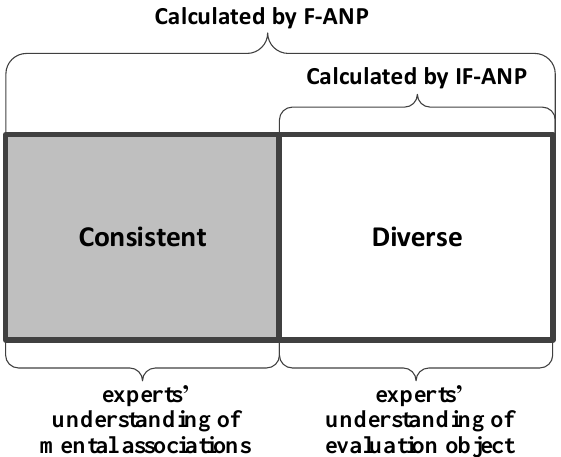
Figure 5. Difference between the IF-ANP and direct evaluations.